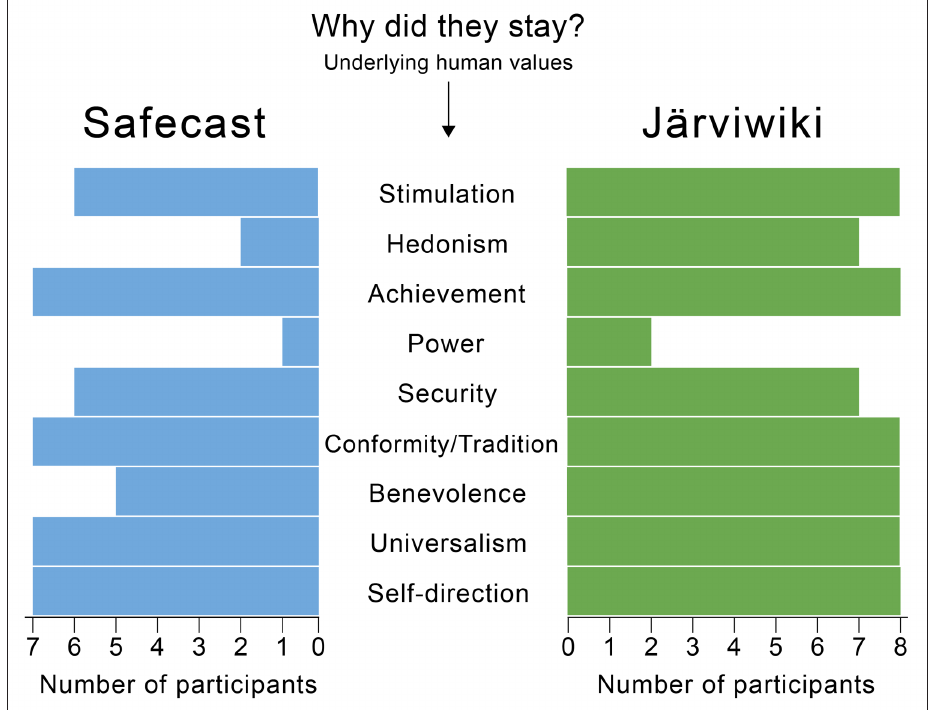
Figure 8: Values underlying sustained participation among Safecast and Järviwiki RQ 3: How do motivations align with values in the studied cases?